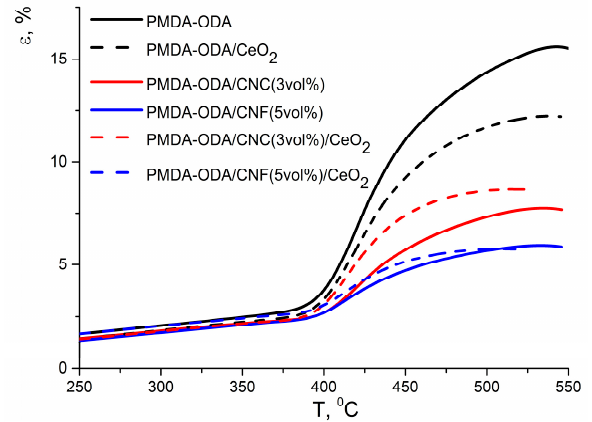
Figure 6. Thermomechanical analysis (TMA) curves of the PMDA-ODA and the corresponding nanocomposites.